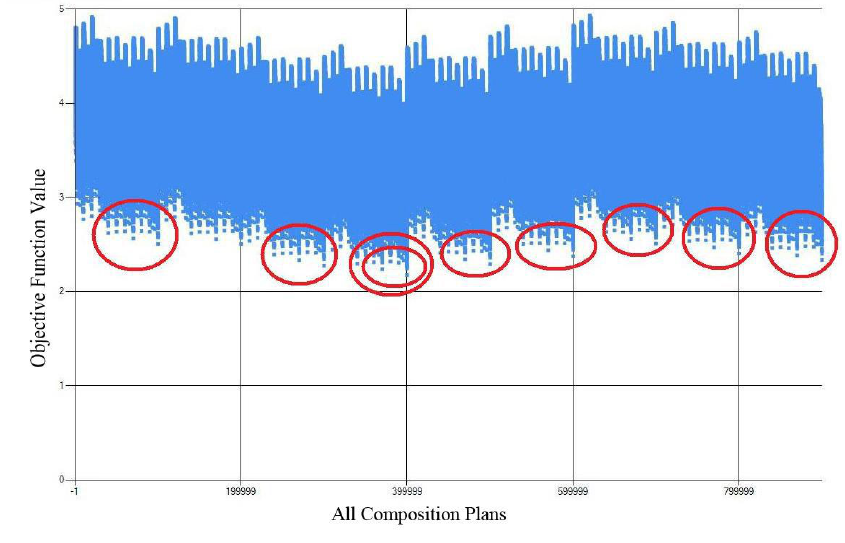
Figure. 8. Value of all plans in example with 6 tasks and 10 web services. Table 6. Relation between Local and global optimum WS number Percentage of repeat in best plan